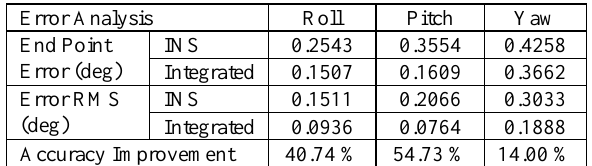
Table 8. Analysis for attitude